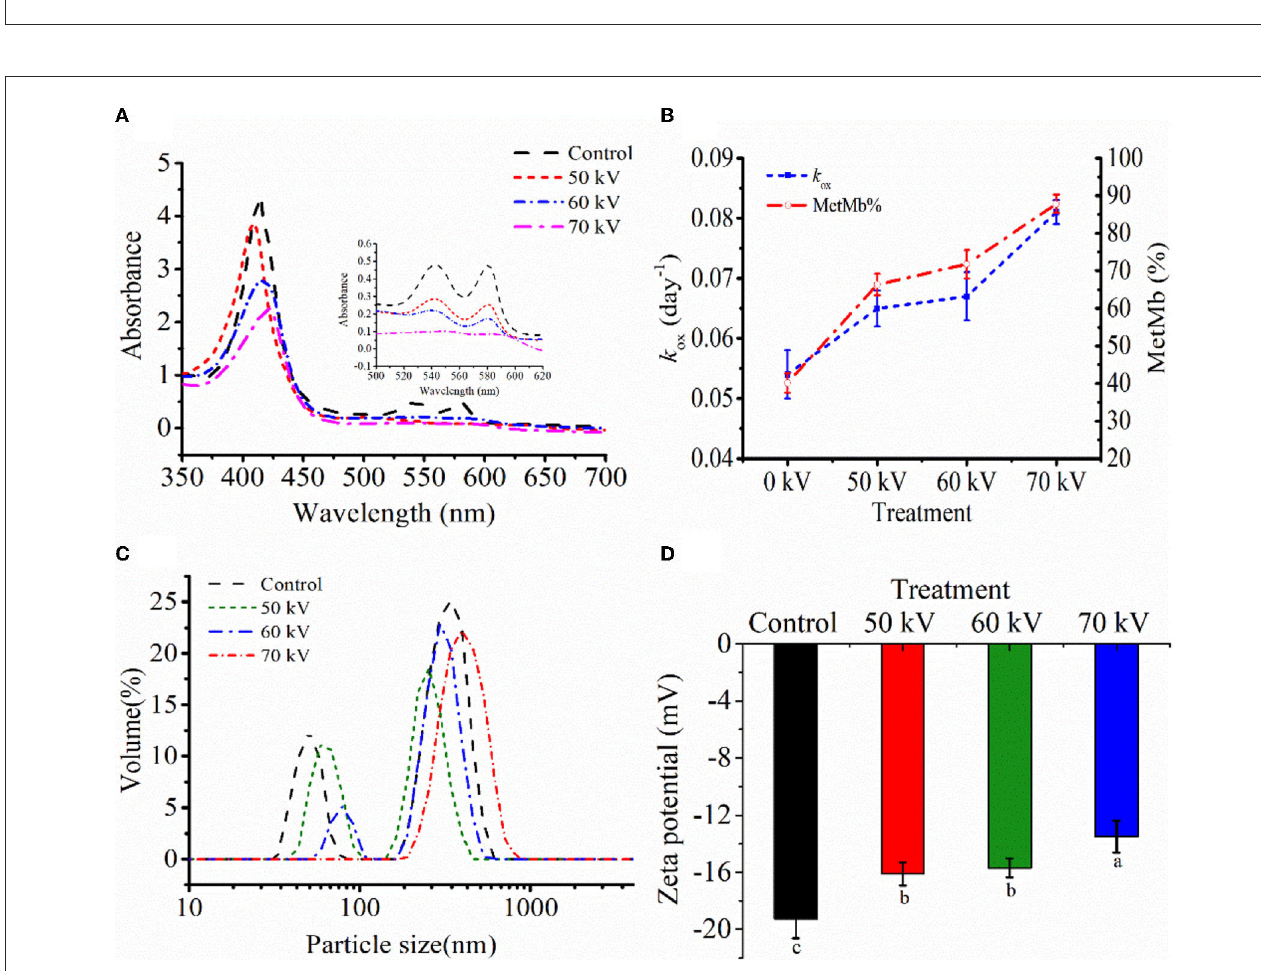
FIGURE3 (A) The UV absorption. (B) metMb proportion and autoxidation rate ( k ox ), (C) particle size distribution, and (D) zeta potential of myoglobin with and without DBD-CP treatment. k ox is equivalent to the probability of decay of a single molecule to the ferric form in 4 days. Note: Control, protein without DBD-CP treatment; The remaining groups were treated by DBD-CP at 50, 60, 70 kV, and 50Hz for 180s, respectively. The operating frequency was 50Hz. Replicates per treatment were n = 3. Means and standard deviations are